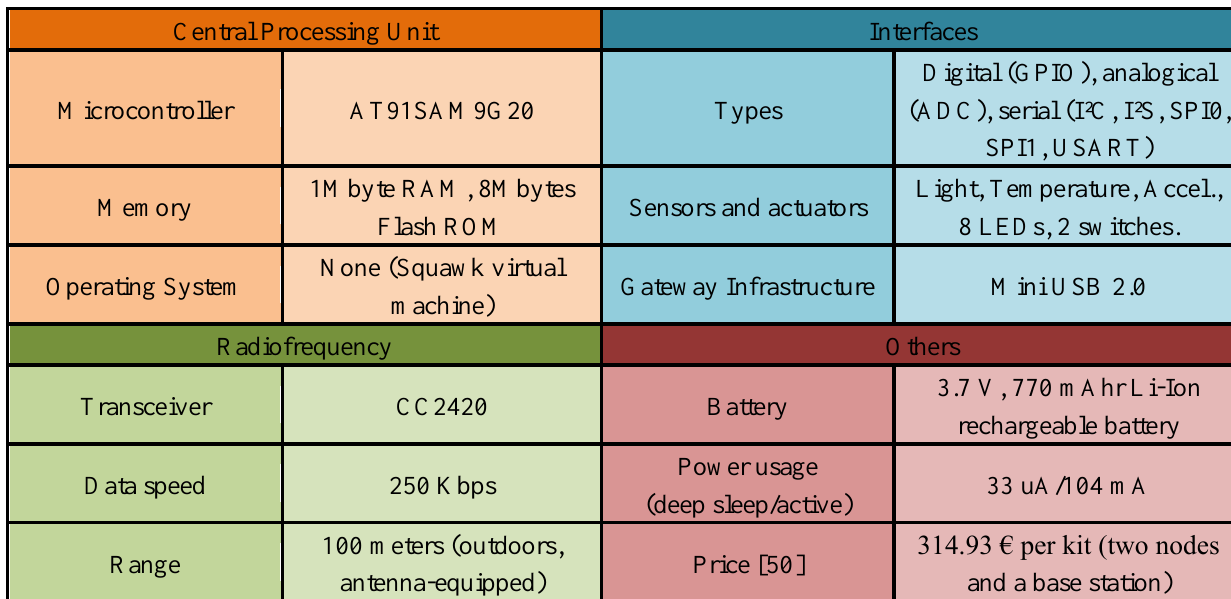
Table 1. Sun SPOT node technical features as of its latest release